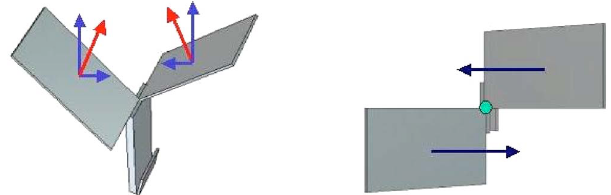
FIG. 1. (cid:1) Color (cid:2) A schematic diagram of the paper “helicopter” or “rotor” with the drag force and its components along the vertical and horizontal directions. The perspective from top (cid:1) on the right- hand side (cid:2) only shows the force component that produces the torque to make the paper helicopter rotate.